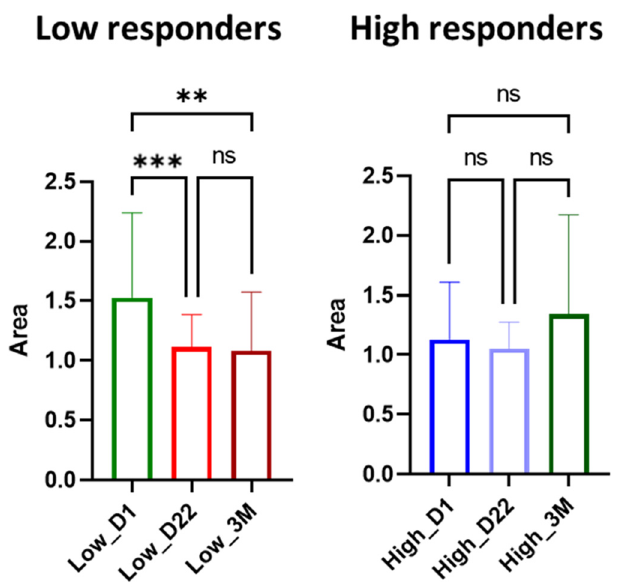
Figure 7. Comparison of the Cer(d18:0/22:0) levels, employing ANOVA test, among the three time points; Day 1 (D1), Day 22 (D22) and 3 Months (3M) for low and high responders. Asterisks indicate statistical significance: *** 0.0001 < p < 0.001, ** 0.001 < p < 0.01; ns: not significant.